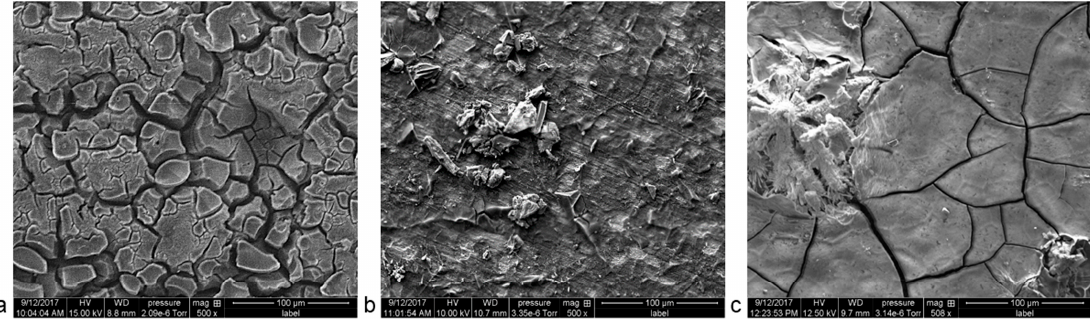
Figure 7. Surface morphology after 48 h of the EN test of ( a ) pure Mg, ( b ) pure Zn, and ( c ) Zn – 0.5Al.